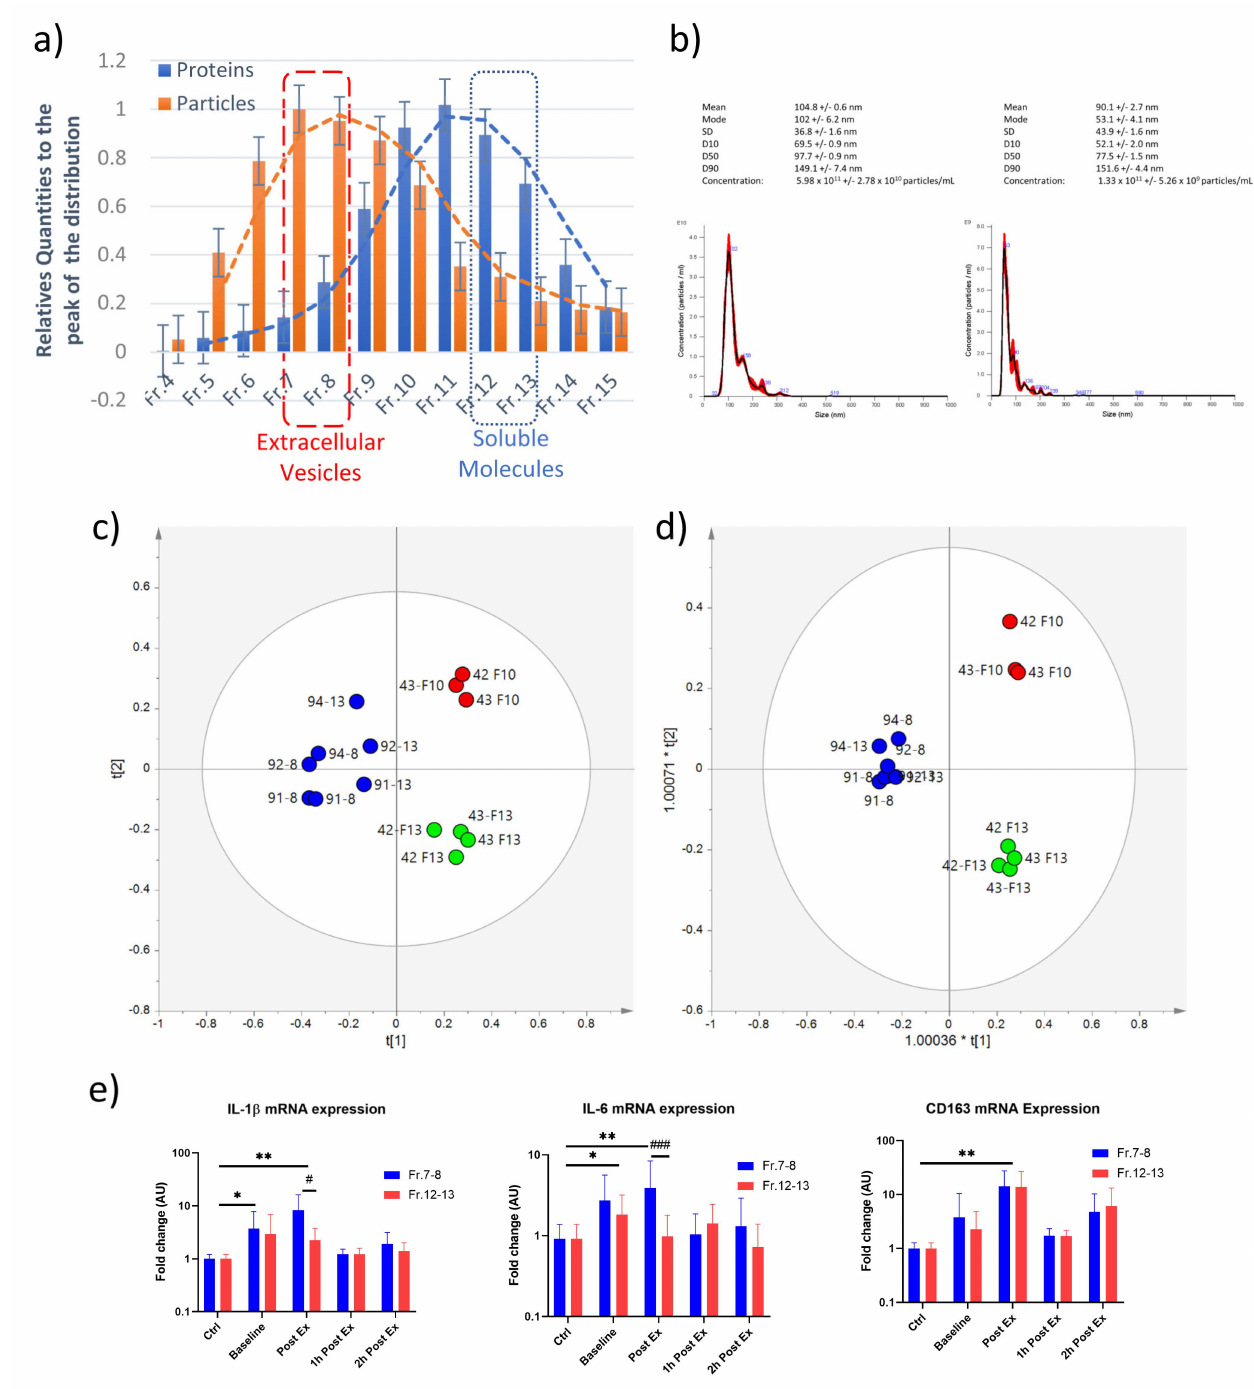
Figure 9. Size exclusion chromatography separation of EVs from plasma, separated EVs were quantified using NTA, whereas soluble factors were estimated by using Bradford protein assay ( a ). Size distribution plot of EVs collected from Fr. 7 and Fr. 13 ( b ). Partial least squares discriminant (PLS-DA) ( c ) and orthogonal partial least squares discriminant (OPLS-DA) ( d ) analyses performed on a partial dataset of EV lipid extracts. ( e ) Inflammatory effect of vesicular (Fr. 7–8) and soluble (Fr 12–13) factors isolated following acute aerobic exercise; THP-1 cells were incubated for 18 h with circulating factors and mRNA expression levels IL-1 β , IL-6 and CD163 were evaluated by real- time qPCR. ANOVA test followed by Dunnett’s post hoc analysis vs. Ctrl; * p ≤ 0.05; * * p ≤ 0.001; # p ≤ 0.05, ### p ≤ 0.001 Fr 7–8 vs. Fr